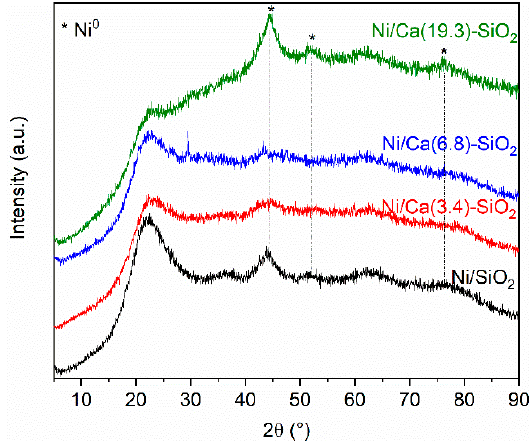
Figure 1. X-ray di ff ractograms of reduced Ni / SiO 2 and Ni / Ca(X)-SiO 2 catalysts. Figure 1. X-ray diffractograms of reduced Ni/SiO 2 and Ni/Ca(X)-SiO 2 catalysts. The XRD patterns of Ni / SiO 2 and Ni / Ca(19.3)-SiO 2 catalysts exhibit broad peaks which could The XRD patterns of Ni/SiO 2 and Ni/Ca(19.3)-SiO 2 catalysts exhibit broad peaks which could be be assigned to the Ni species. The XRD peaks at 2 θ = 44.5 assigned to the Ni species. The XRD peaks at 2 θ = 44.5°, 51.9°, and 76.4° indicate the presence of metallic nickel (JCPDS 04-0850), although small broad peaks at 2 θ = 37.2 metallic nickel (JCPDS 04-0850), although small broad peaks at 2 θ = 37.2°, 43.3° and 62.9° reveal that there is also oxidized nickel phase (JCPDS 47–1049) there is also oxidized nickel phase (JCPDS 47–1049) [21].